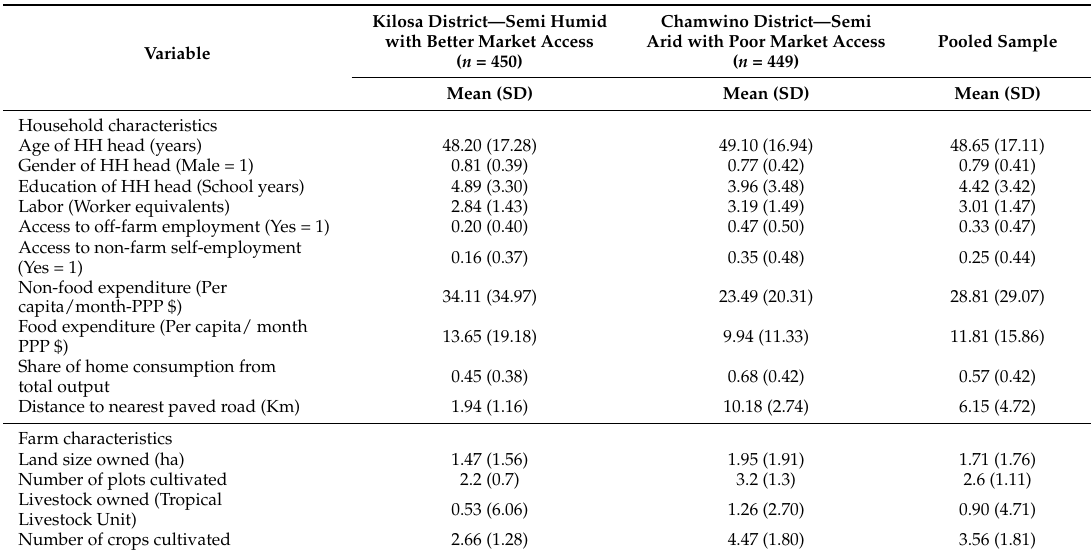
Table 2. Selected household and farm